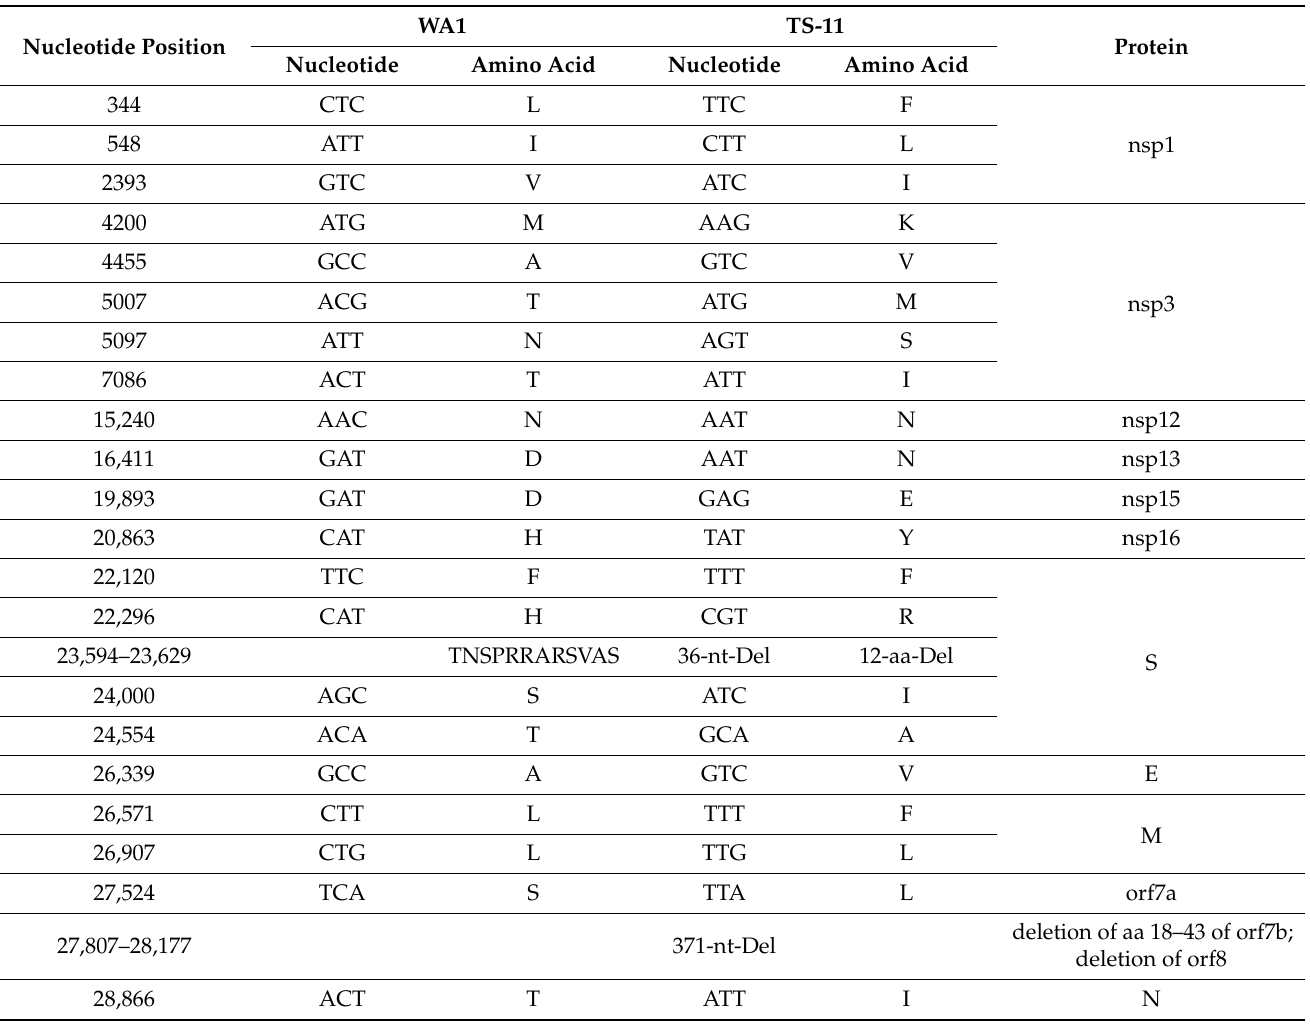
Table 1. Mutation sites of SARS-CoV-2 TS11 compared with WA1